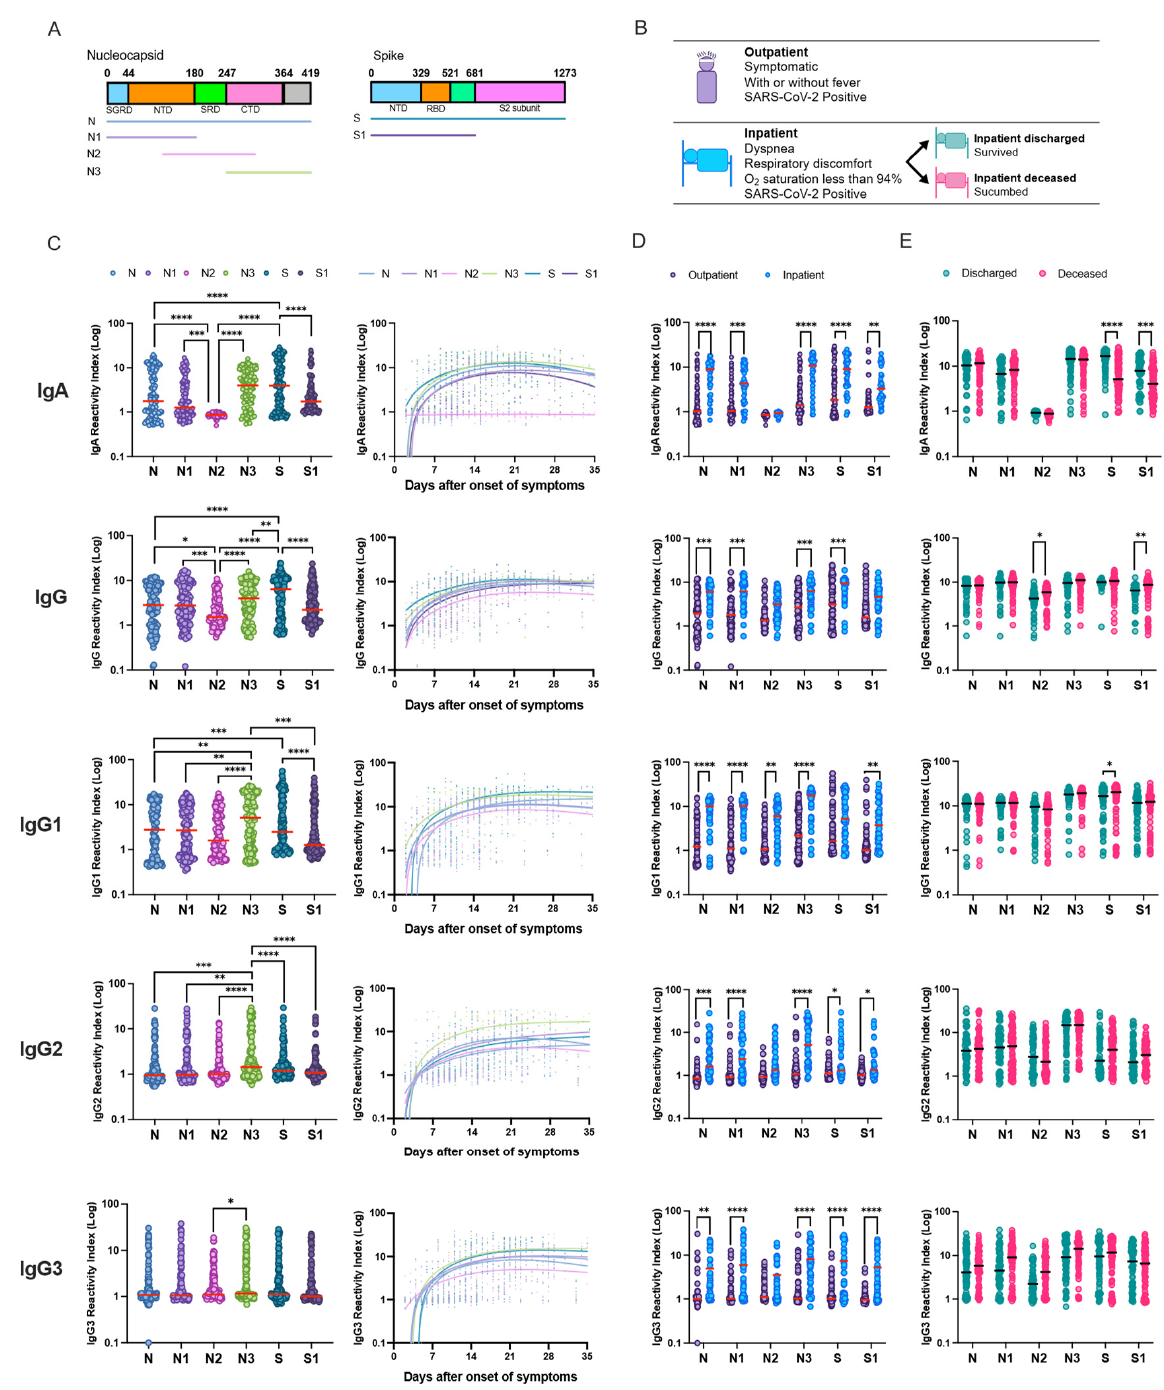
Figure 1. SARS-CoV-2 nucleocapsid and spike proteins elicit a robust IgA, total IgG and IgG-subclass response in COVID-19 patients. ( A ) Sketch depicts SARS-CoV-2 full-length and truncated nucleocapsid (N) and spike (S) proteins. ( B ) RT-PCR confirmed COVID-19 patients (n = 128) with non-severe disease (outpatient n = 80) and hospitalized patients with severe disease (inpatient n = 48) included in the study. ( C – E ) 100 ng of purified SARS-CoV-2 proteins were coated on ELISA plates and 1:100 patient serum dilution was used in an indirect ELISA to estimate serum IgA, IgG and IgG-subclass response. Antigen-specific antibody response among ( C ) all COVID-19 patients, ( D ) outpatients and inpatients, and ( E ) discharged (n = 24, samples n = 59) and deceased (n = 24, samples n = 72) inpatients was compared. Reactivity index (RI) values were calculated as a ratio between sam- ple optical density and pre-pandemic negative samples. Horizontal red or black lines denote the median antibody range. Each curve in the graph represents reactivity towards each antigen, Splines were plo tt ed using the Fit Spline program in GraphPad Prism software. ANOVA test with Tukey’s post hoc test was used to compare di ff erences in the RI between antigens. Two-way ANOVA with Šidák post hoc correction for multiple comparisons. * p < 0.05, ** p < 0.01, *** p < 0.001, **** p < 0.0001.